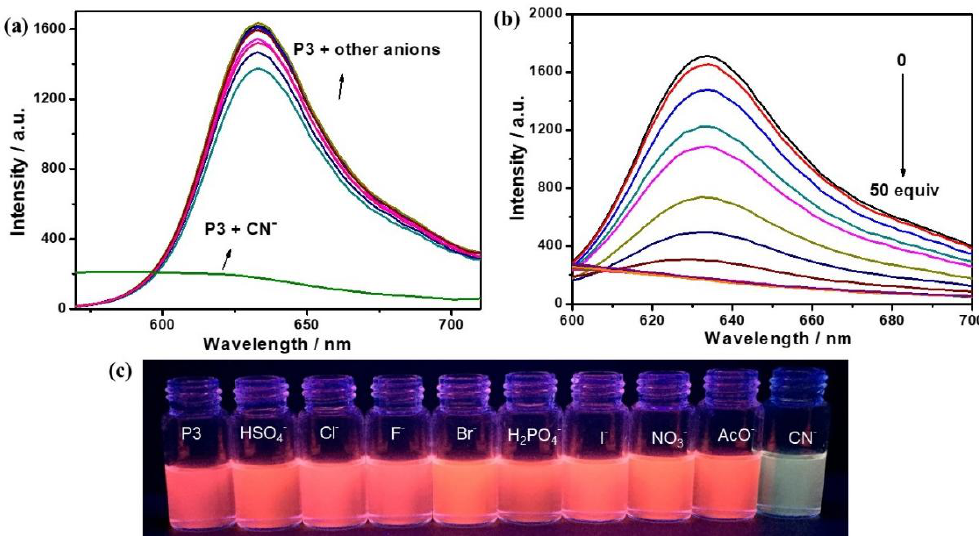
Figure 7. ( a ) Fluorescence spectra of P3 ([RU] = 30 µ M) in THF/H 2 O (98:2, v/v ) in the presence of 20 equiv. of different anions, λ ex = 365 nm; ( b ) fluorescence spectral changes of P3 ([RU] = 30 µ M) in THF/H 2 O (98:2, v/v ) upon addition of an increasing concentration of CN − (0, 120, 240, 270, 300, 330, 360, 390, 420, 450, 480, 510, 540, 570, 600, 700, 800, 900, 1000, 1200 and 1500 µ M), λ ex = 365 nm; and ( c ) fluorescence observed for P3 solutions upon addition of 50 equiv. each anion under the excitation of 365